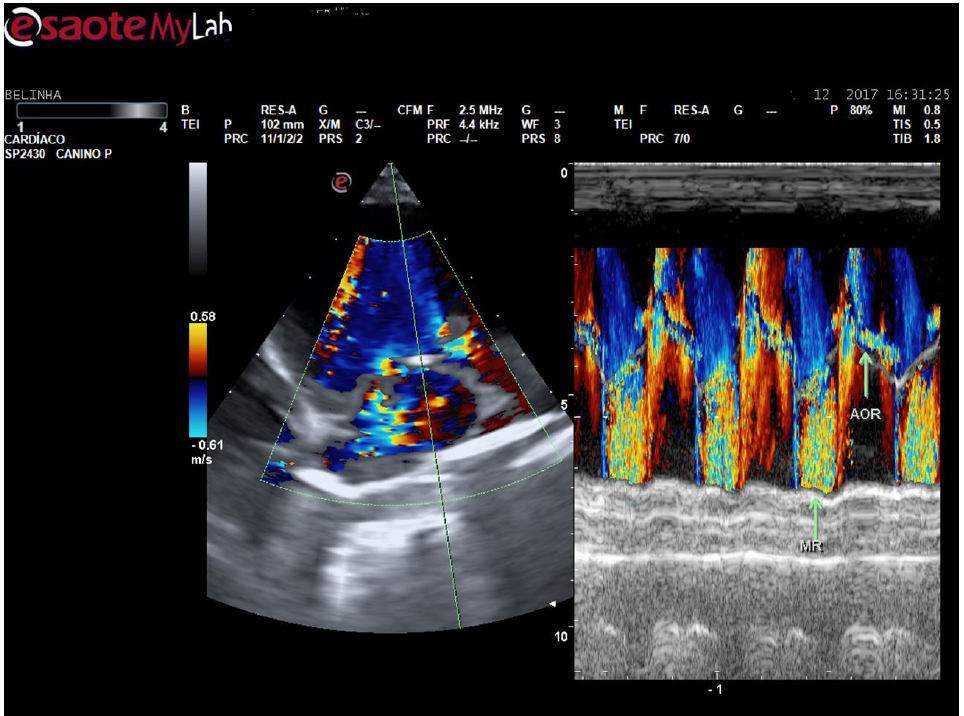
Figure 6. The color Doppler M-mode during sinus rhythm, demonstrating permanence of aortic (AOR) and mitral regurgitation (MR) and absence of atrioventricular diastolic